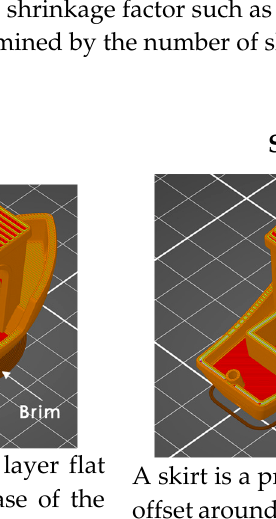
Figure 4. Definition of raft, brim and skirt.